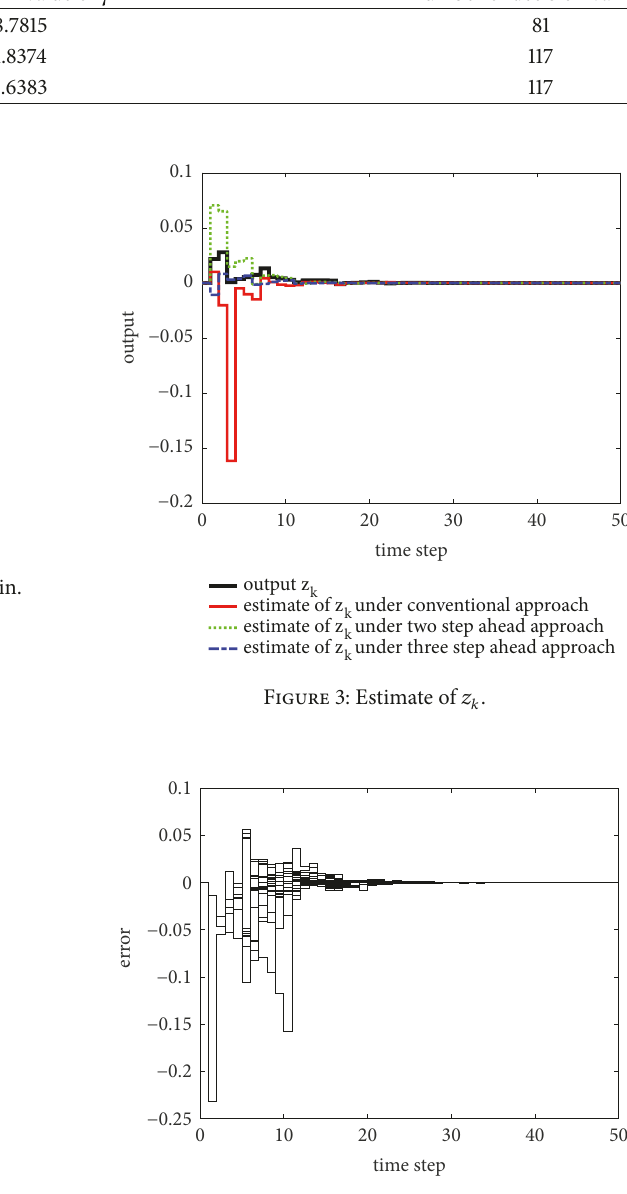
Figure 4: Monte Carlo simulation of estimated